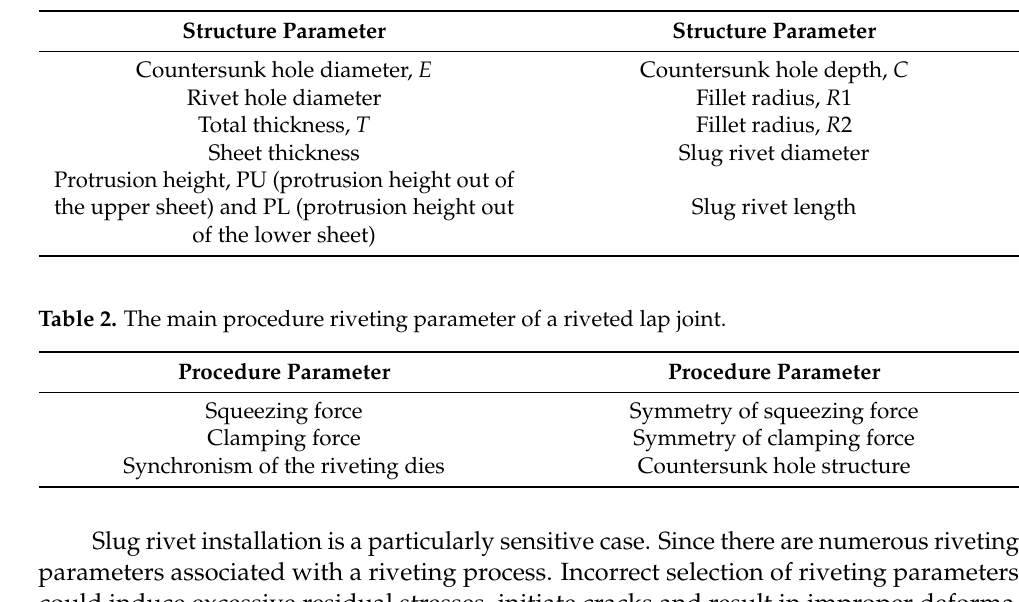
Table 2. The main procedure riveting parameter of a riveted lap joint.